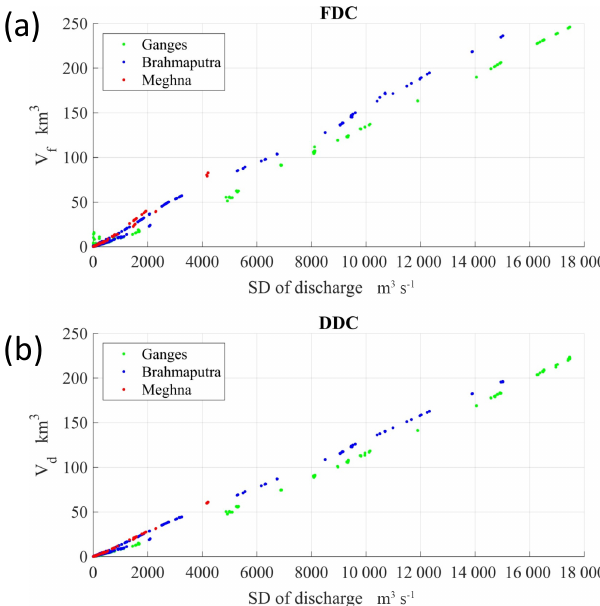
Figure 14. Relation between necessary storage (km 3 ) and SD (m 3 s − 1 ) of discharge at all grid points in the GBM basin for (a) flood and (b) drought